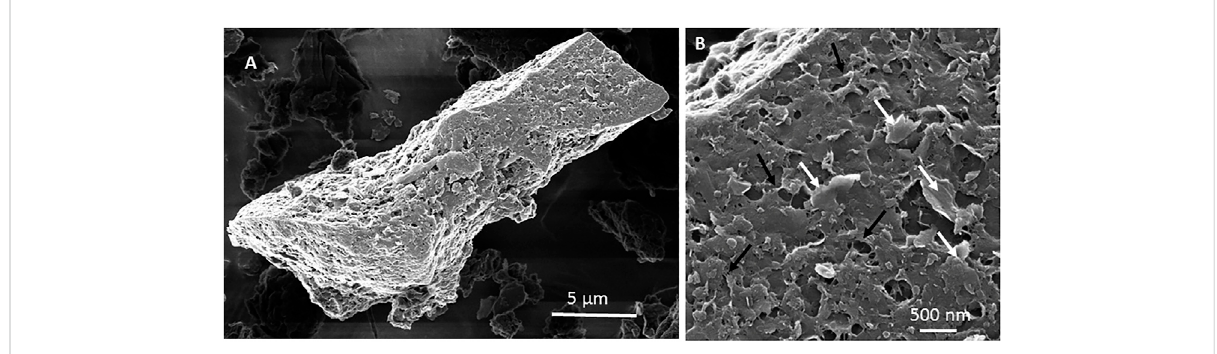
FIGURE 4 Alteration of the surface of a plagioclase fragment from crushed basalt by a Hadean seawater simulant at 73 ° C (A) showing rapid coating of the whole surface by minute clay particles (B) , white arrows. Note also that the mineral particle is coated with a “ conditioning layer ” of organic matter automatically precipitated from the ambient water (black